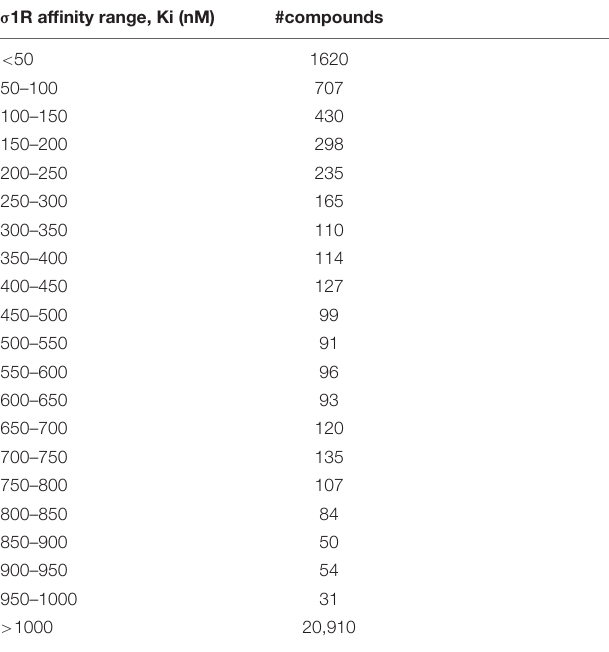
TABLE 1 | Experimentally determined σ 1R affinity range distribution of compounds in the dataset of 25,676 unique structures used for virtual screening and validation of the different